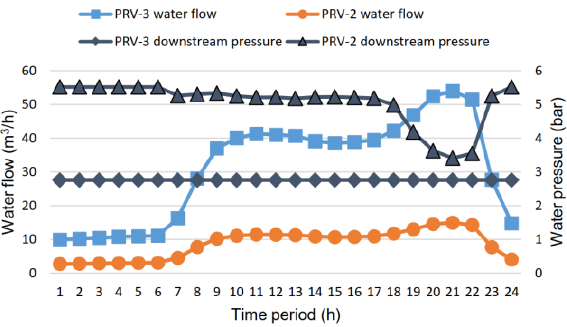
Figure 9. Water flow through PRV-2 and PRV-3 and their corresponding downstream pressure.